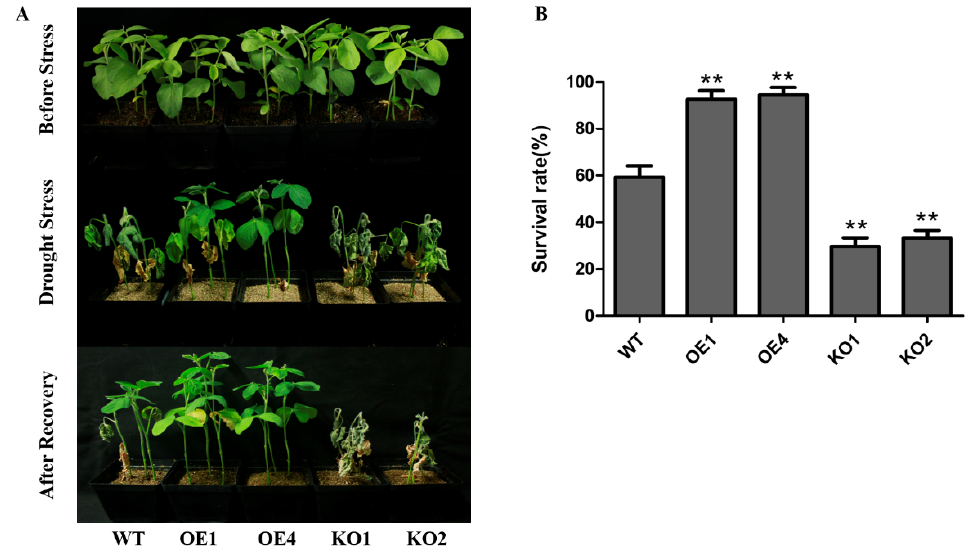
Figure 3. GmNAC12 positively regulated drought tolerance in soybean. ( A ) Performance of wild-type (WT) plants, GmNAC12 overexpression lines (OE1 and OE4), and GmNAC12 knockout lines (KO1 and KO2) under drought stress and after recovery. ( B ) Survival rate of wild-type plants, GmNAC12 overexpression lines, and GmNAC12 knockout lines after recovery ( n = 3). Over 30 plants in each line were used for survival rate analysis. The data represent the means ± SEs. ** p < 0.01 (Student’s t -test).